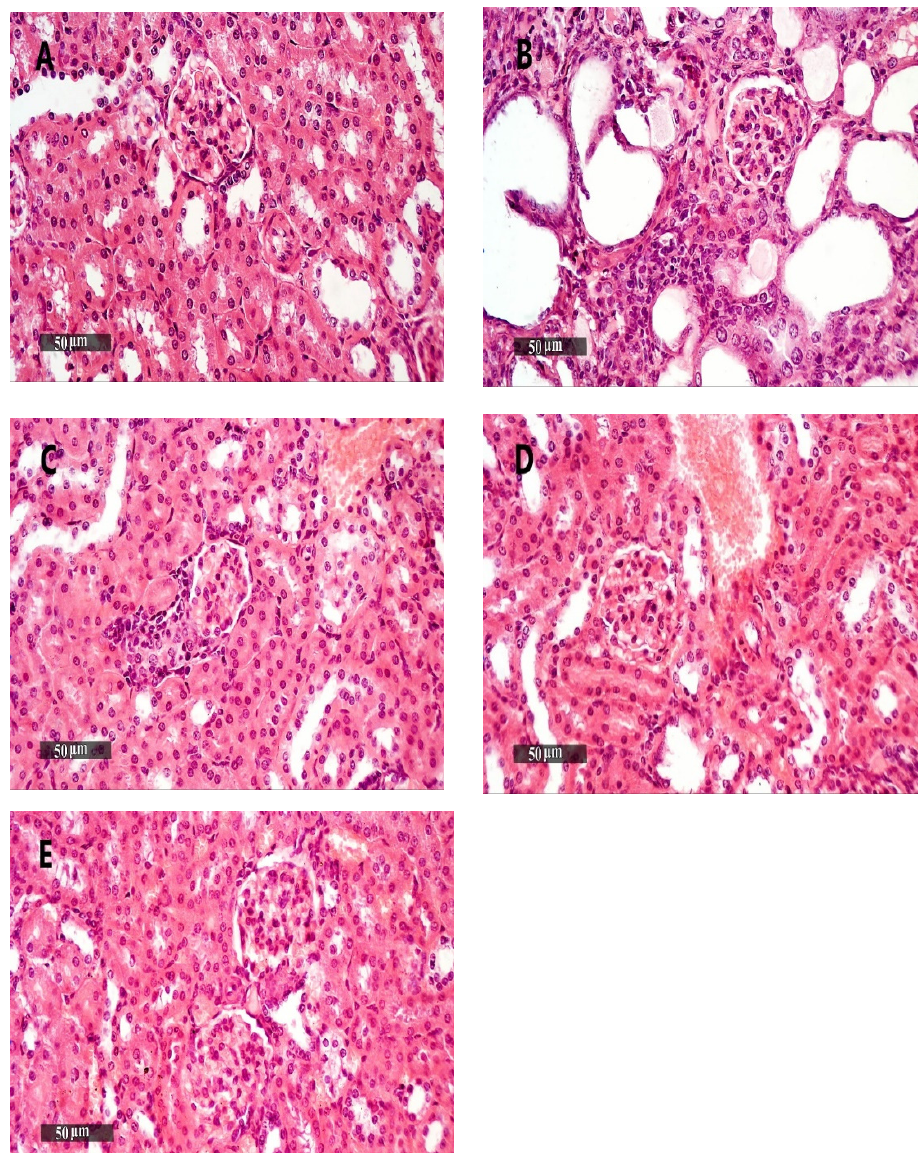
Figure 10. Kidney samples stained with H&E. ( A ) An image for a kidney specimen from the vehicle + empty gel group showing apparent intact morphological features of renal parenchyma, including renal corpuscles and different nephron tubular segments, including tubular epithelium, with intact interstitial tissue, as well as vasculatures. ( B , D ) Images for a kidney specimen from the DMBA + empty gel or DMBA + ethosome gel showing a mild cystic dilatation of renal tubular segments, with some flattening of the tubular epithelial lining. ( C ) An image for a kidney specimen from the DMBA + free metformin gel group showing mild focal records of tubular degenerative changes with intact renal corpuscles, as well as interstitial tissue with very few sporadic inflammatory cell infiltrates. ( E ) An image from DMBA + metformin ethosome gel samples showing little focal tubular degenerative changes with intact renal corpuscles, interstitial tissue and vasculatures, scale bar = 50 µ